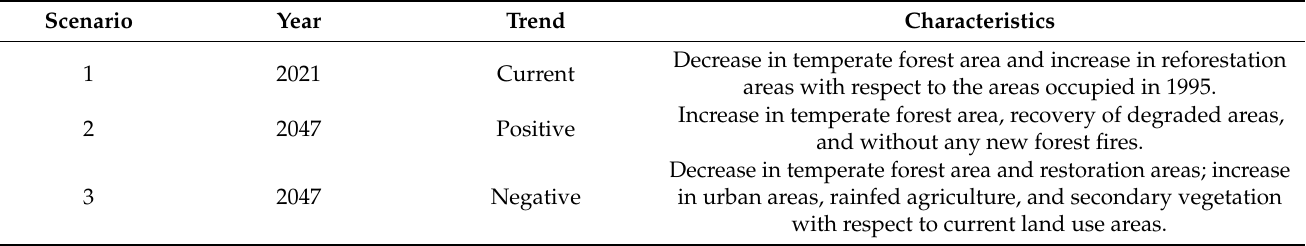
Table 3. Main characteristics of the land use change